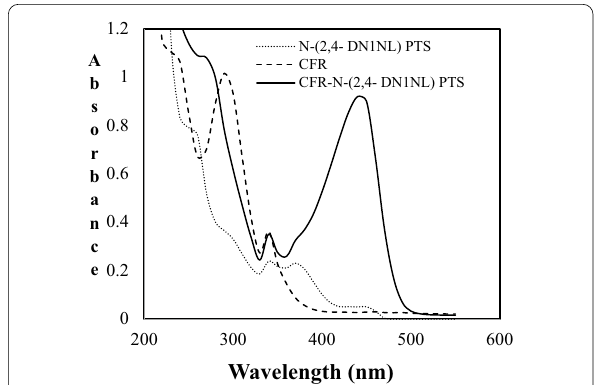
Fig. 1 The overlaid absorption spectra of reagent (N-(2,4-DN1NL) PTS), drug (CFR) and adduct formed. The spectra were produced following UV scanning of the reagent, drug and adduct at wavelength range of 600–200 nm. The non-continuous lines represent the reagent, dashed lines, and the drug, while the continuous lines refer to the drug adduct